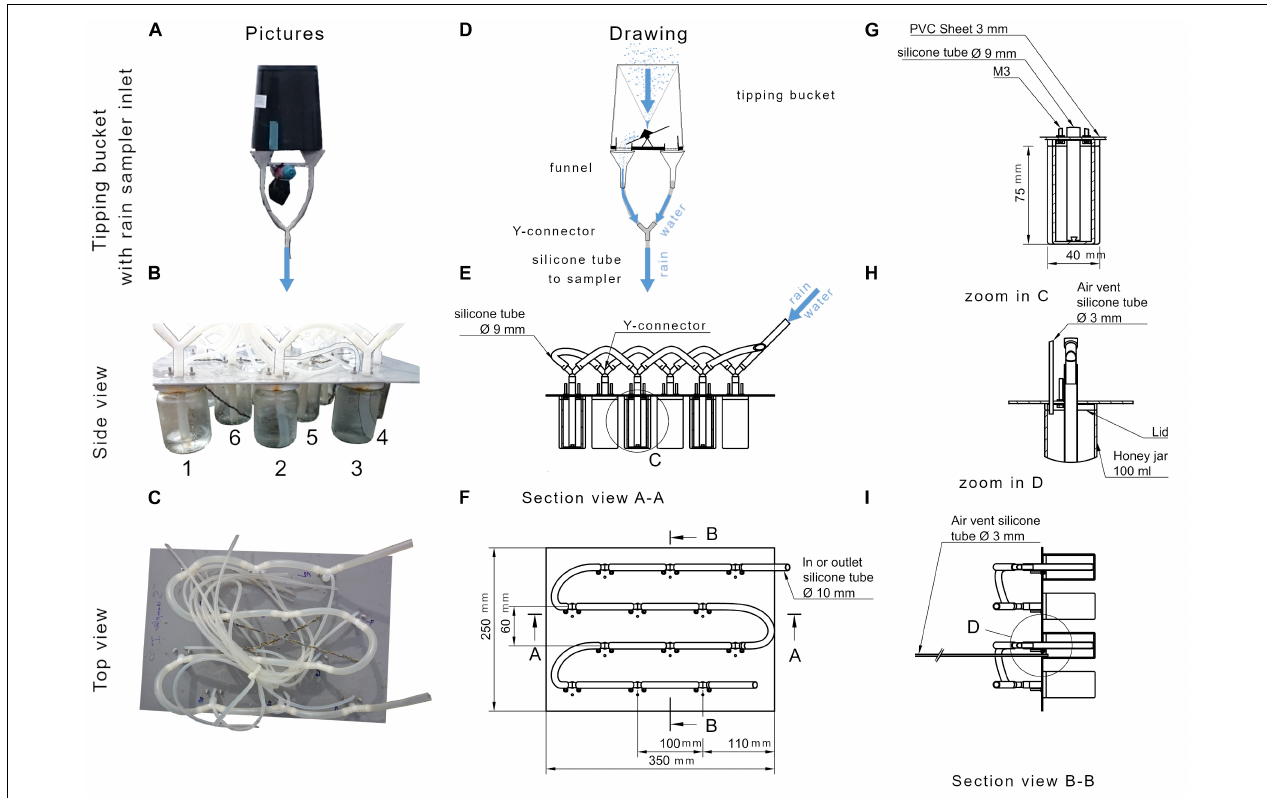
FIGURE 1 | Overview of the ZRS-sampler tipping bucket with attached funnels (A) , side view (numbers indicate sample bottles, each 100 ml or 5 mm of precipitation), side view (B) is an example of a malfunctioning sampler where in rainfall event June 2016, honey jar 1 and 2 (left to right) were leaking (not full) and therefore not properly sampling, resulting in mixing of water of different isotopic composition and top view (C) . Drawing of the tipping bucket (D) , section view A–A (E) , top view (F) , zoom in C (bottle and connections) (G) , zoom in D (air vent and connection of glass) (H) , and section view B–B (I) . In case the study requires a high or lower temporal resolution, i.e., rainwater samples representing < 5 mm or > 5 mm rainfall amount, it is possible to connect honey jars with smaller or larger volumes (having a similar honey jar lid